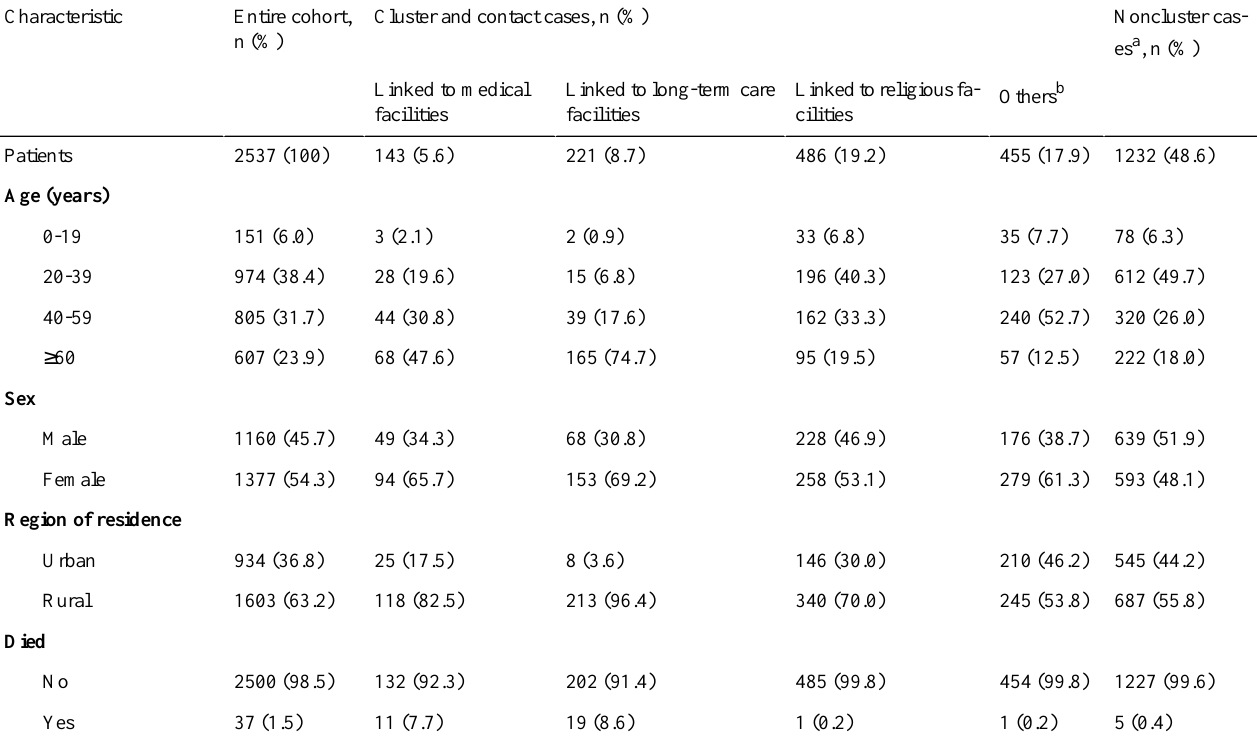
Table 1. Demographic characteristics of patients with confirmed COVID-19 in South Korea.